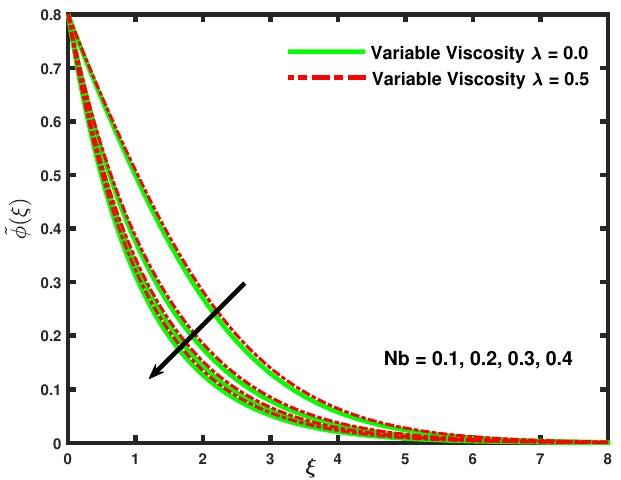
Figure 8. The influence of the Brownian motion parameter ( Nb ) on the Concentration profile.